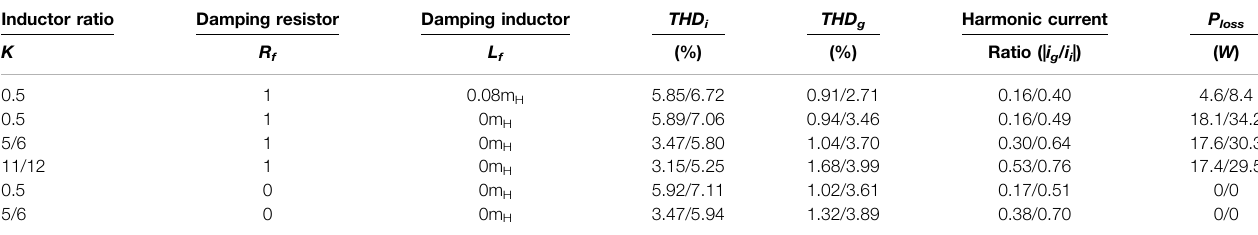
TABLE 4 | Simulation/experimental results comparison of LCL fi lter under different key parameters.